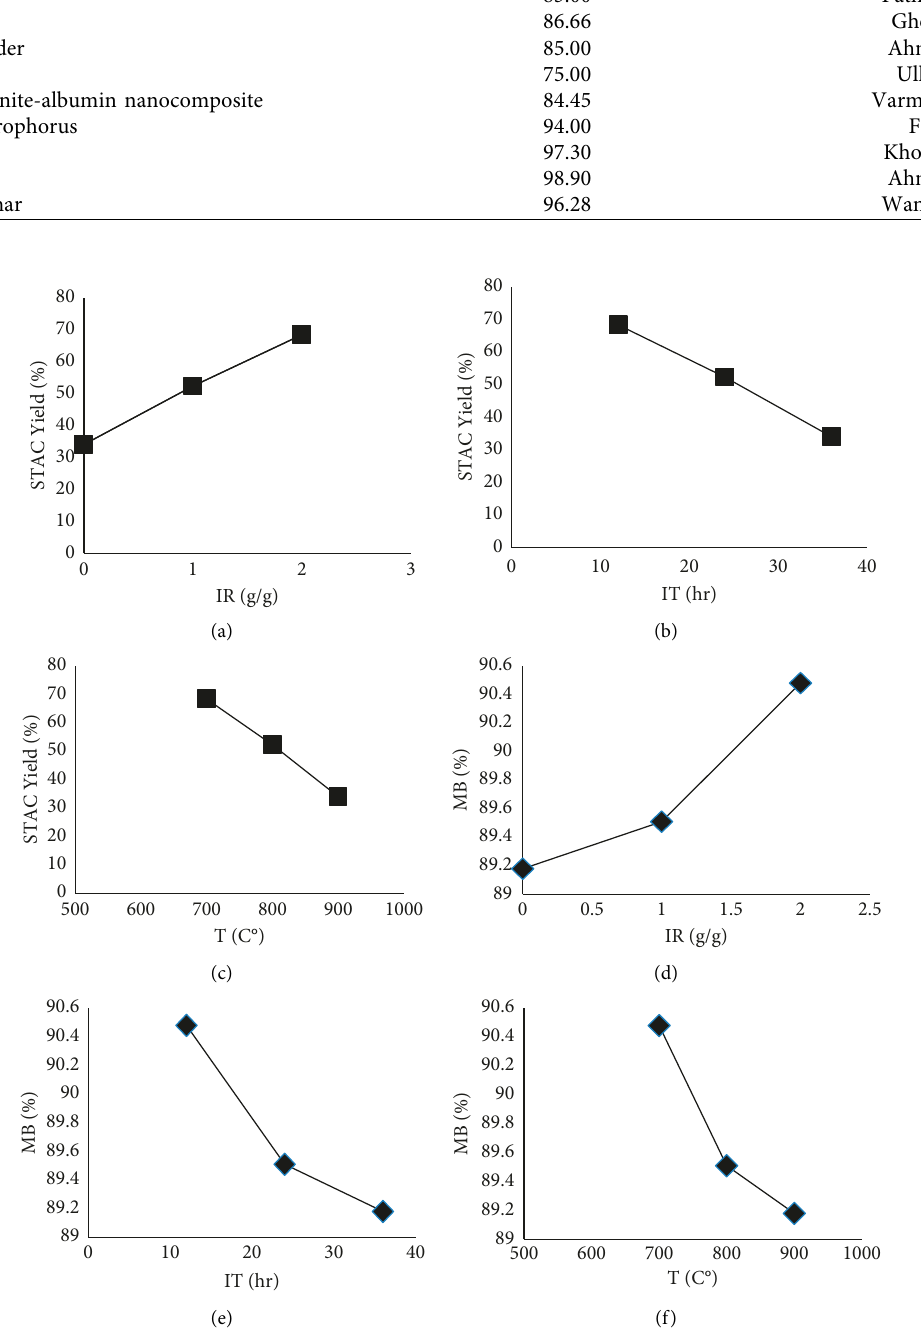
Figure 1: Effect of individual factors on STAC yield (a–c) and MB removal